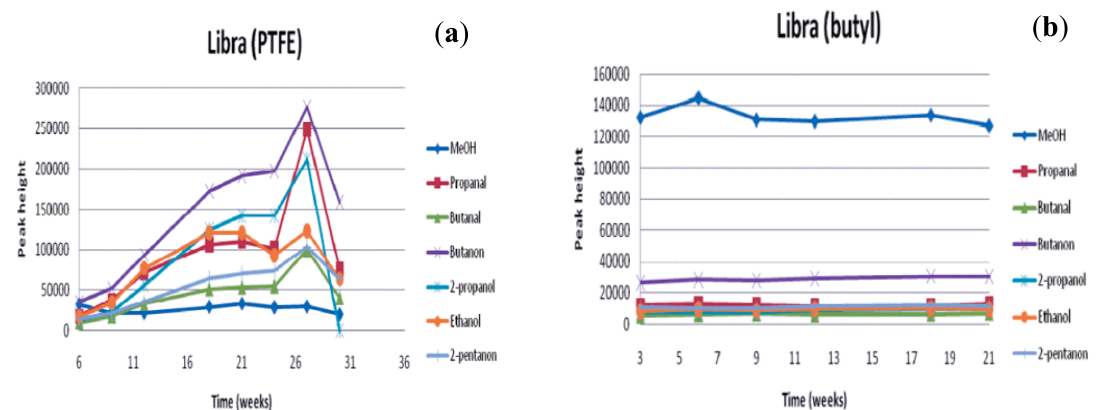
Figure 8. Stability with time of methanol and other compounds when ageing paper in Nynas Nytro Libra oil, ( a ) vials with PTFE caps, ( b ) vials with butyl septa caps, from